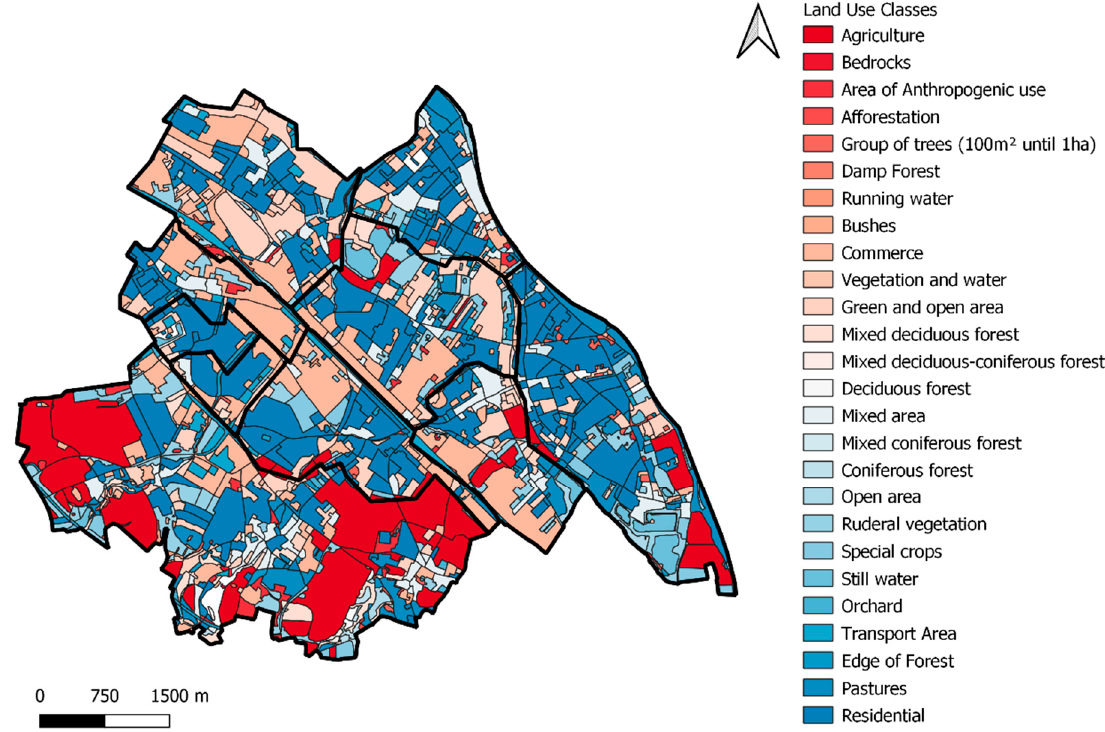
Figure A1. Land use classes in the study area (adapted from [13]).